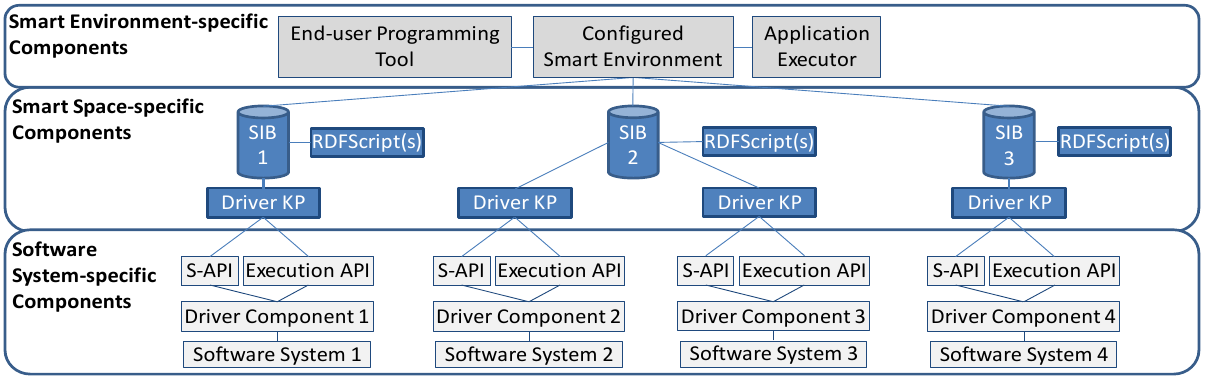
Figure 2. A three-layer framework for end-user programming of cross-smart space applications.